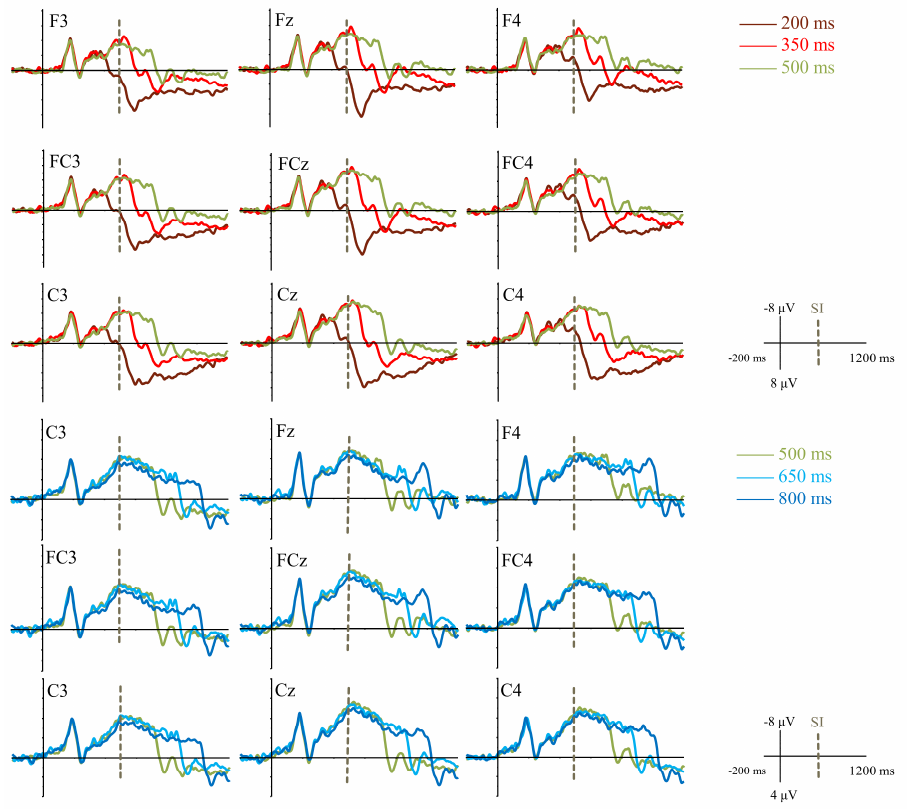
Figure 3. Grand average ERPs induced by different comparison intervals in Experiment 1.